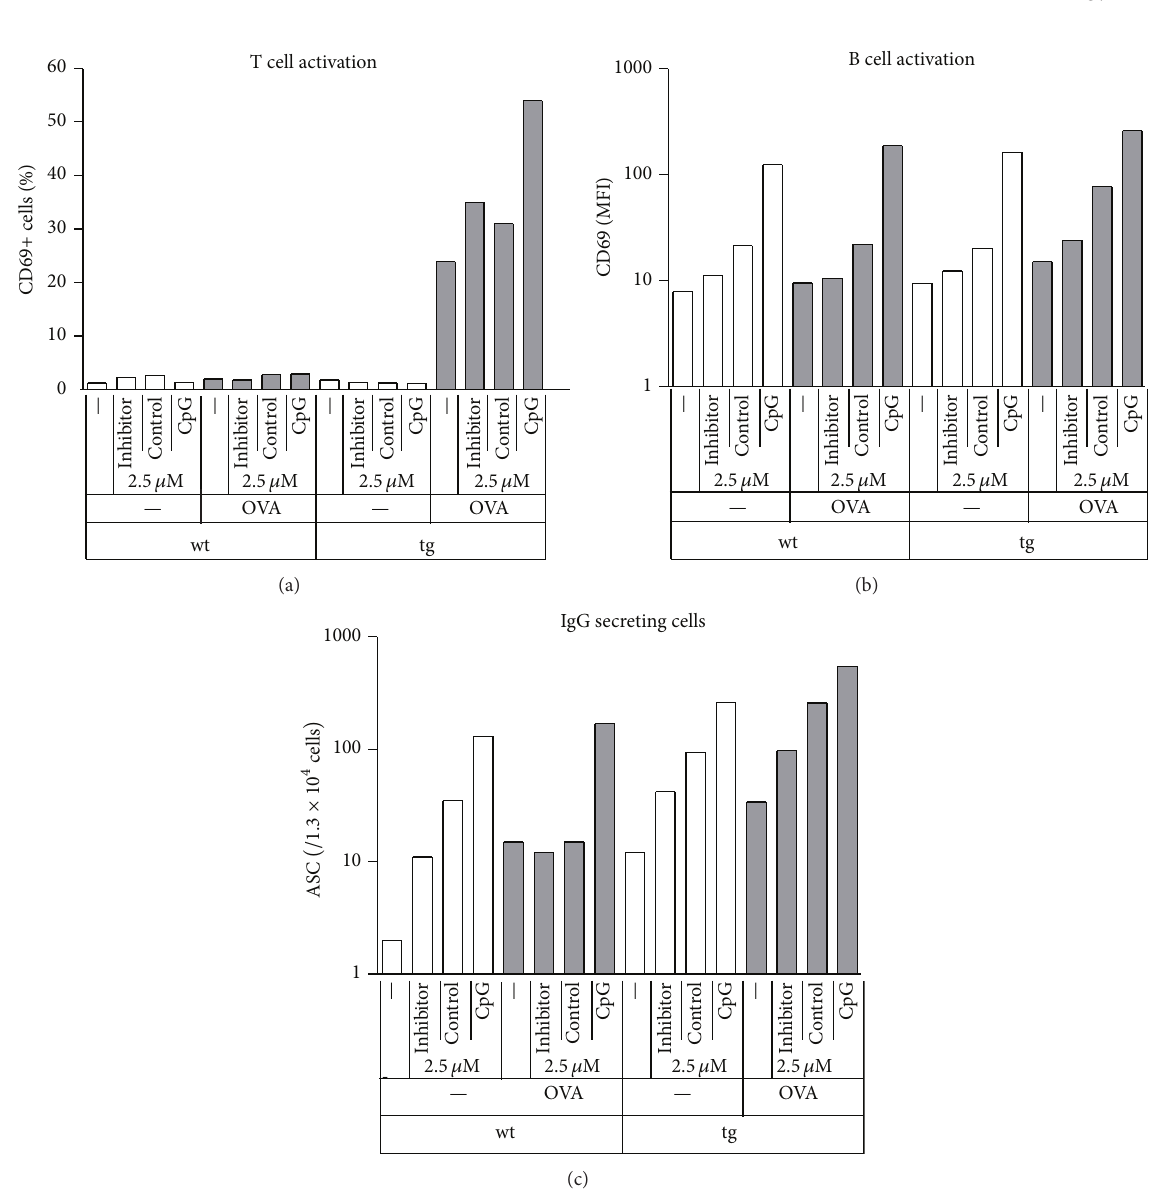
Figure 4: No synergism between OVA and ODN treatments when cognate T cells are not present. Wild type (wt) or TCR transgenic (tg) splenic cells were incubated with different combinations of ODN and OVA for 1 day ((a), (b)) or 4 days (c). After 1 day CD69 expression was measured on B and T cell populations by flow cytometry ((a), (b)). Cells from the 4-day cultures were washed and then transferred onto nitrocellulose-covered slides that were previously coated with light chain capture antibodies. After 10h of incubation, slides were washed and spots indicating IgG producing ASCs were detected using fluorescently labeled antibodies and a fluorescent scanner (c). Results represent a single